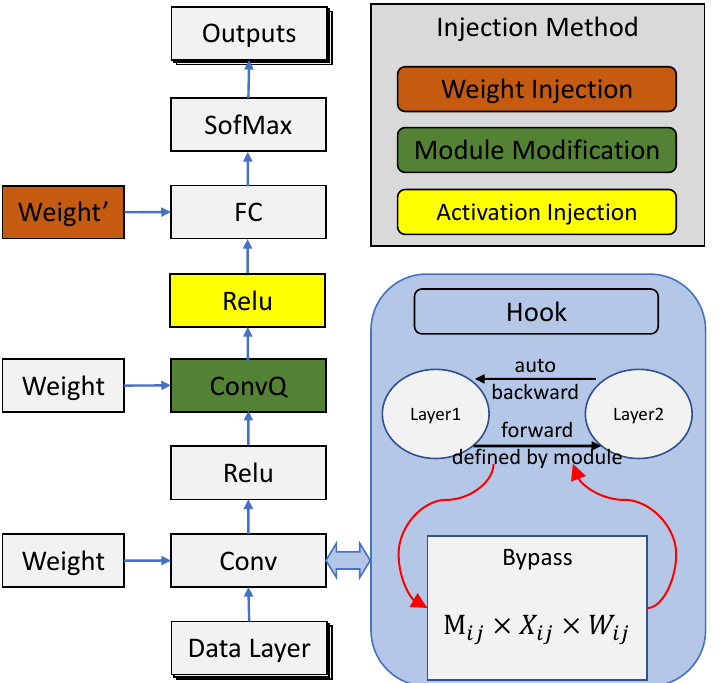
Figure 5. An illustration of the ACIMS fault injection method and Hook. The graph on the lower right outlines how Hook works. The forward procedure is defined by the module, while the backward procedure is generated automatically by the algorithm. To modify the forward procedure while maintaining the backward procedure, Hook employs the bypass